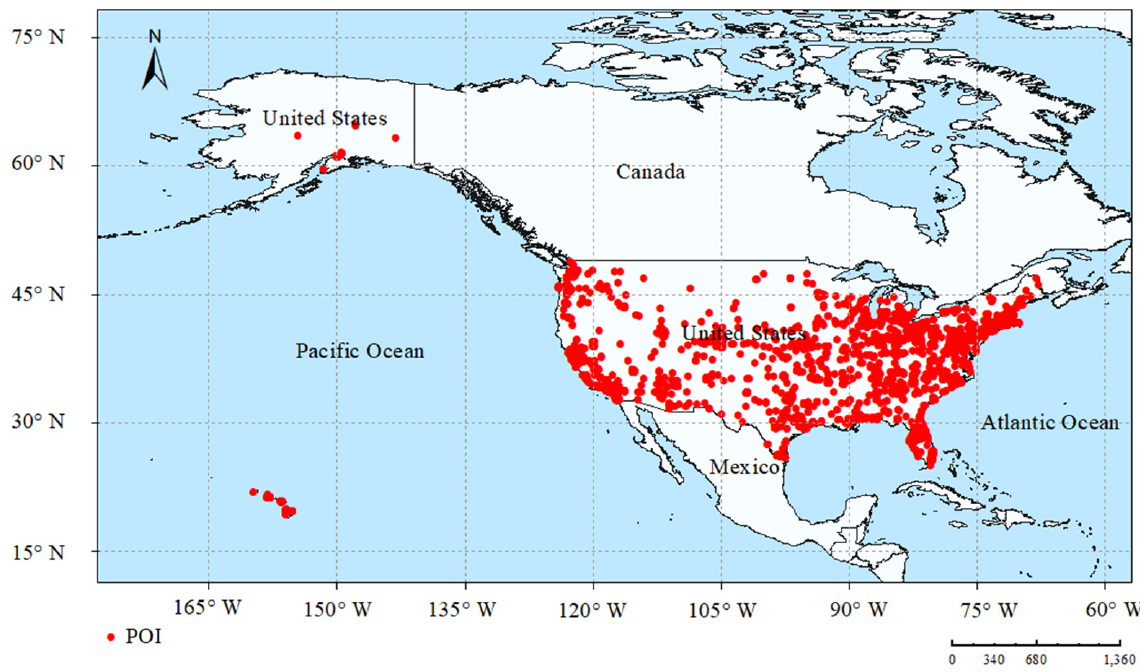
Figure 6. Distribution of check-in data.